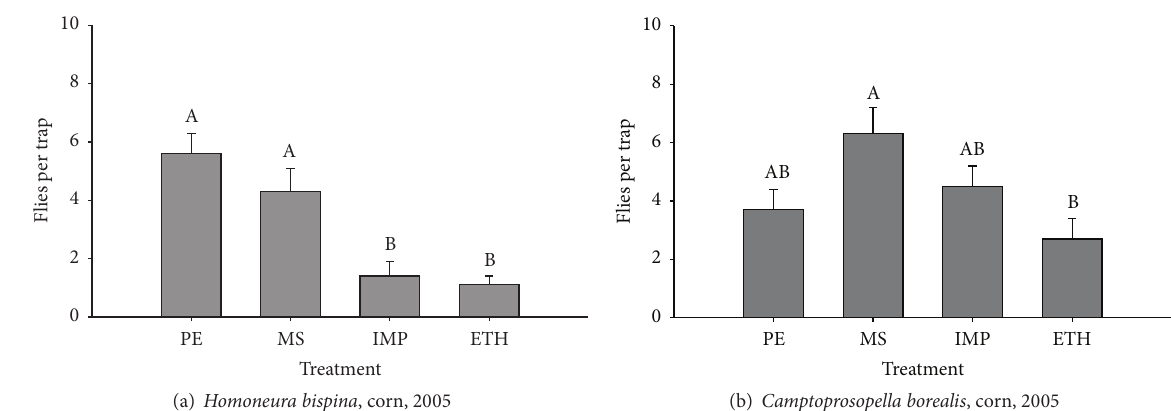
Figure 3: Mean number of lauxaniid flies per sticky trap ( ± SE) baited with volatile chemicals from Jul 13 to Jul 15, 2005, in a corn plot near Brookings, SD (test #4). For each species, bars without the same letters above them indicate that the means differ significantly. PE = 2-phenylethanol, MS = methyl salicylate, IMP = 2-isopropyl-3-methoxypyrazine, and ETH = ethanol (control), each at 100mg on a cotton roll. (a) Adult Homoneura bispina ; (b) adult Camptoprosopella borealis .